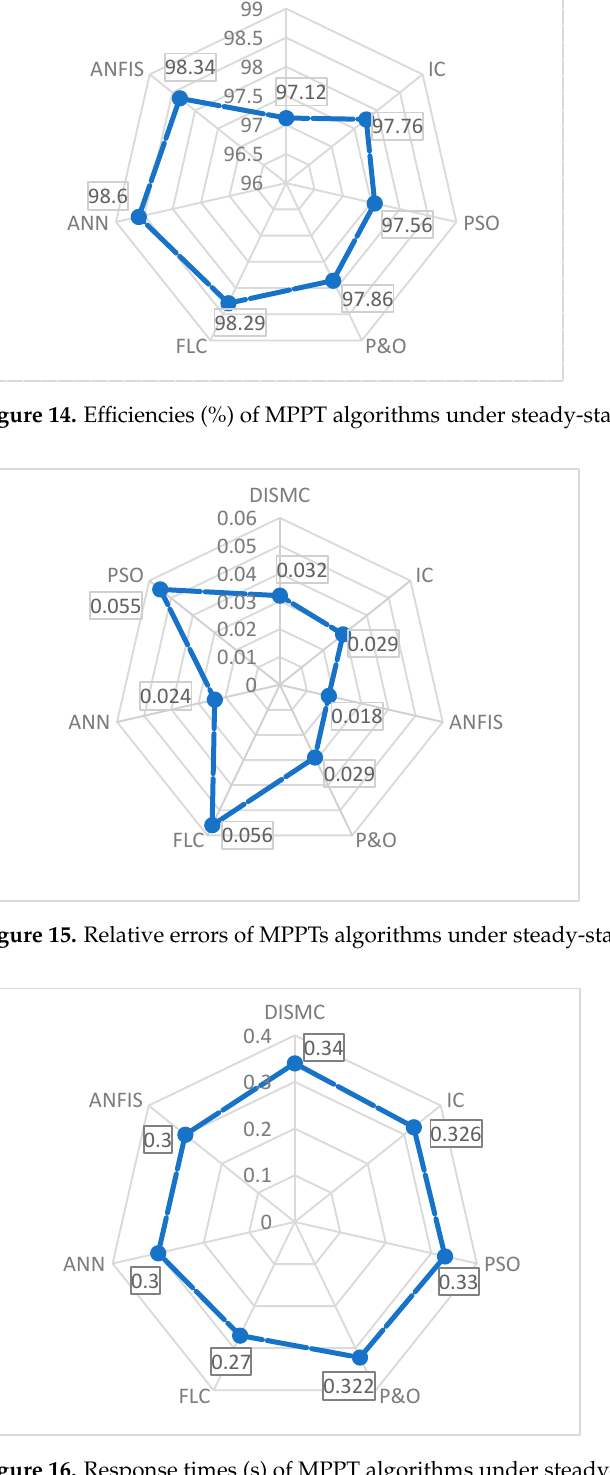
Figure 16. Response times (s) of MPPT algorithms under steady-state weather conditions: Test 1.